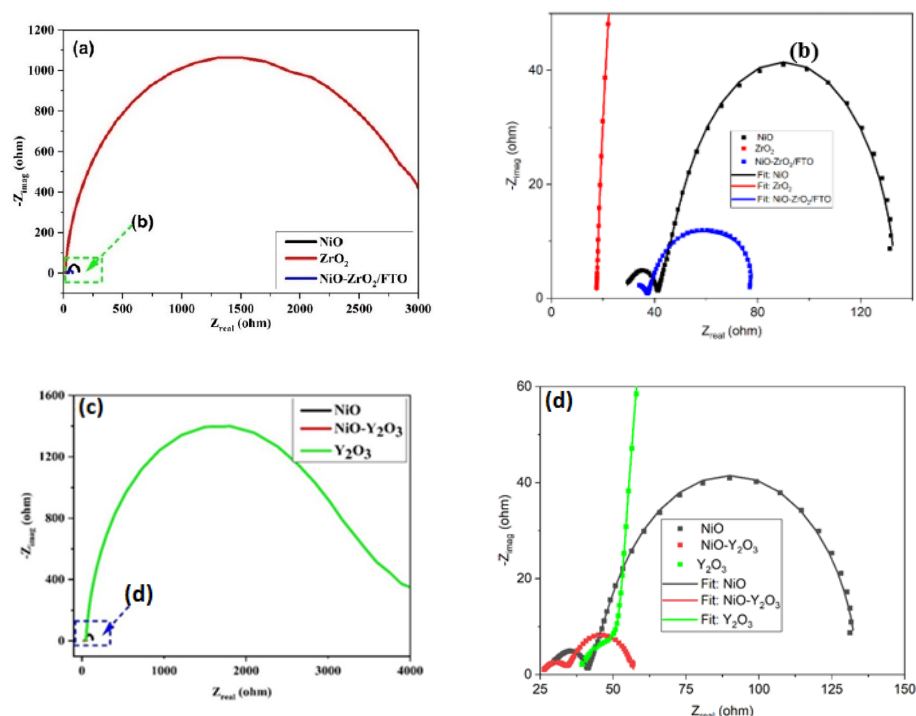
Figure 7. Nyquist plot of ( a ) NiO, ZrO 2, and NiO-ZrO 2 /FTO ( c ) NiO, Y 2 O 3, and NiO-Y 2 O 3 /FTO thin film in 0.5 M NaOH/0.6 M MeOH at 0.6 V. ( b , d ) shows zoomed panel of semicircles with circuit fitting in range of 0–150 Ω .